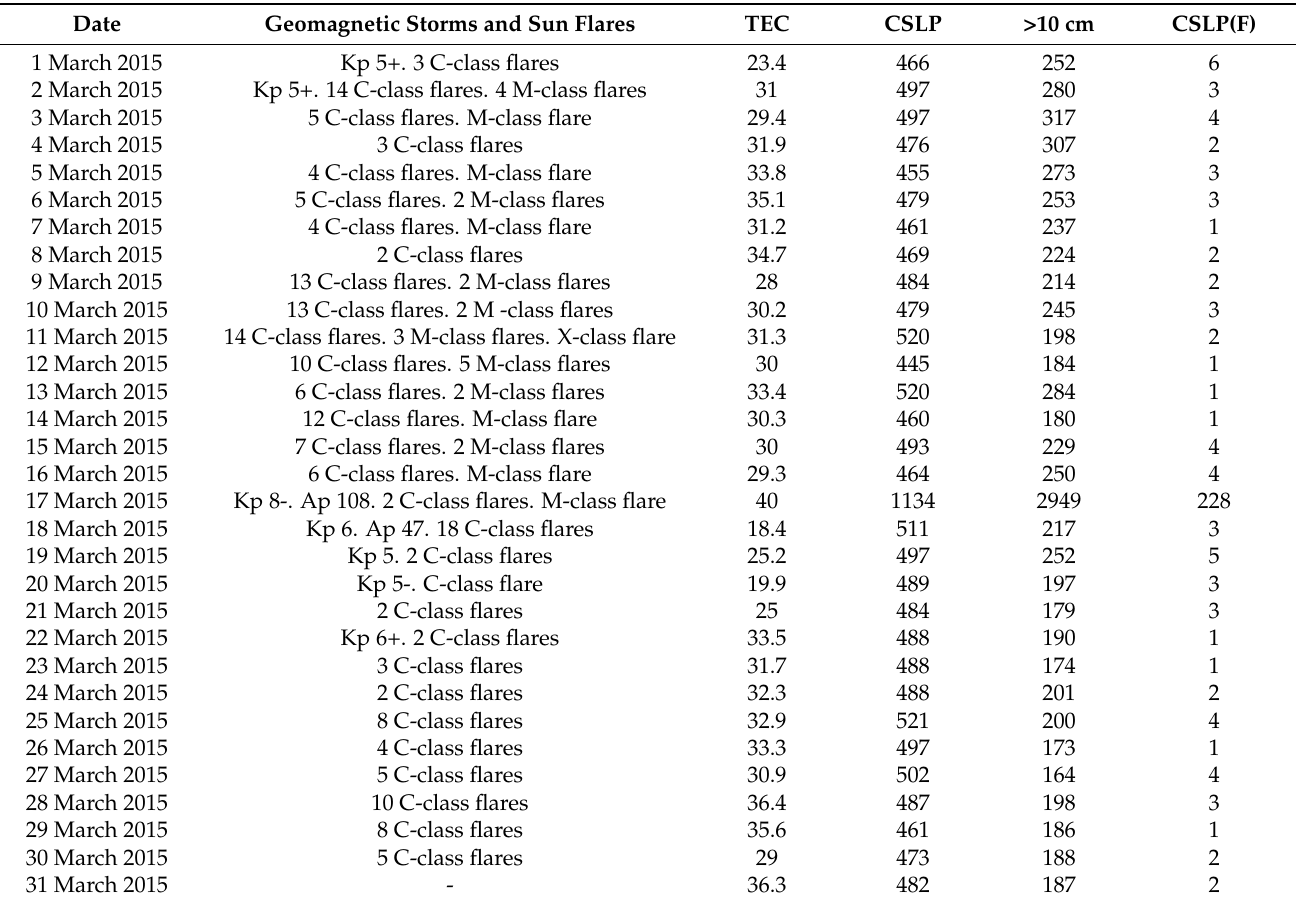
Table 6. Data subset for correlation analysis, March 2015.